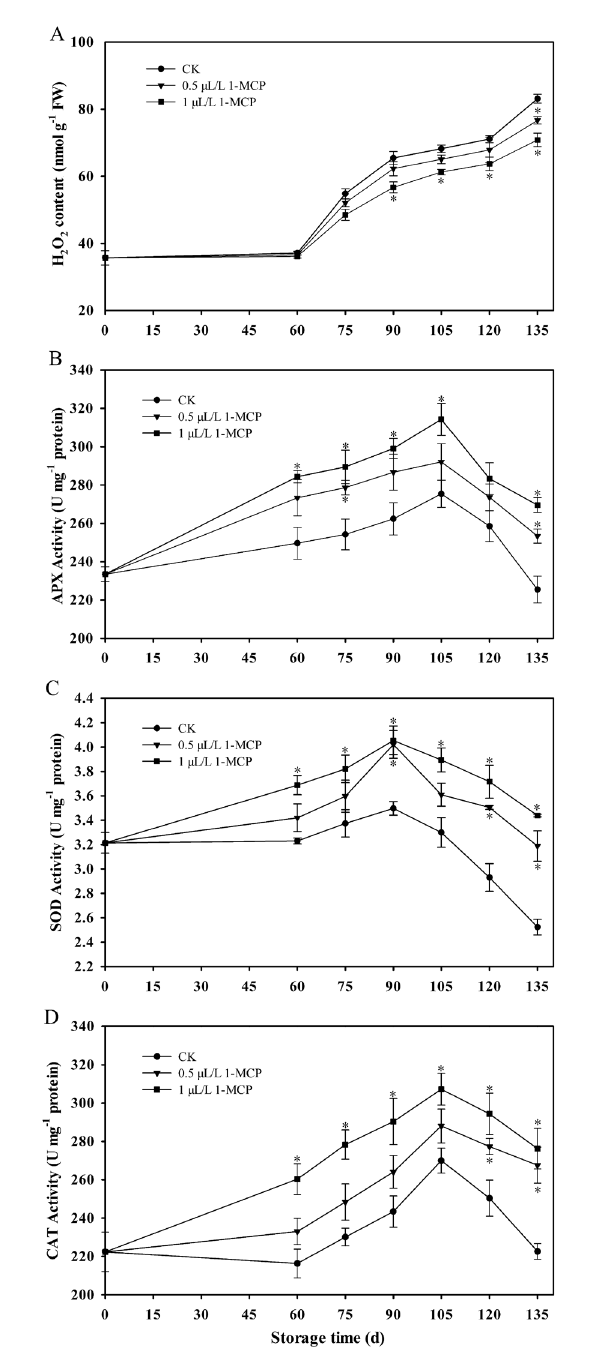
Fig. 2: Effects of 1-MCP on the accumulation of α -farnesene (A) and conjugated trienols (B) in ‘Wujiuxiang’ pear fruits during storage at 0 °C. The data are the means ± SE of three replicates. The vertical bars represent the standard errors of the means. Star represents significant difference ( P < 0.05).